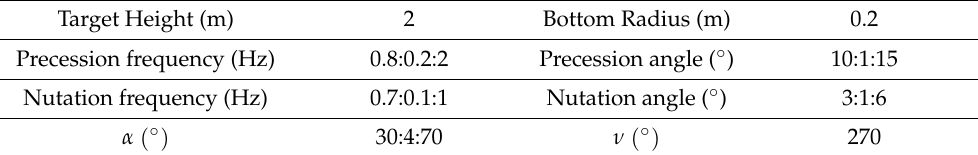
Table 1. Parameters of